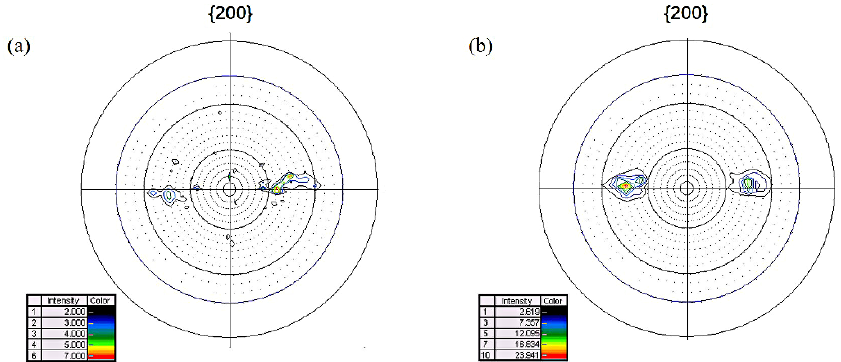
Figure 3. Polar figures detected by XRD for S1 steel ( a ) and S2 steel ( b ) extracted at 1200 °C.